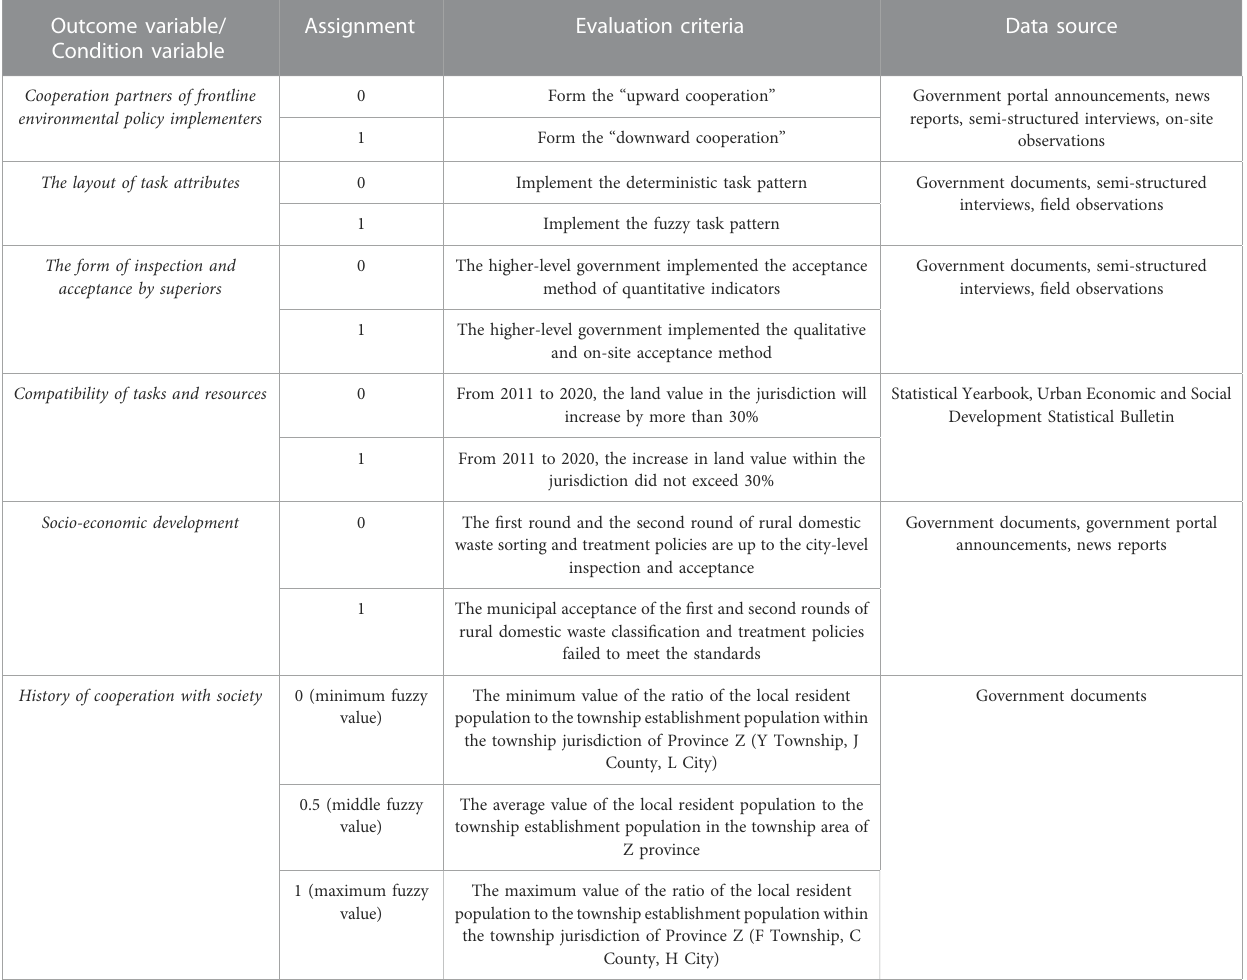
TABLE 2 Calibration thresholds and data sources of